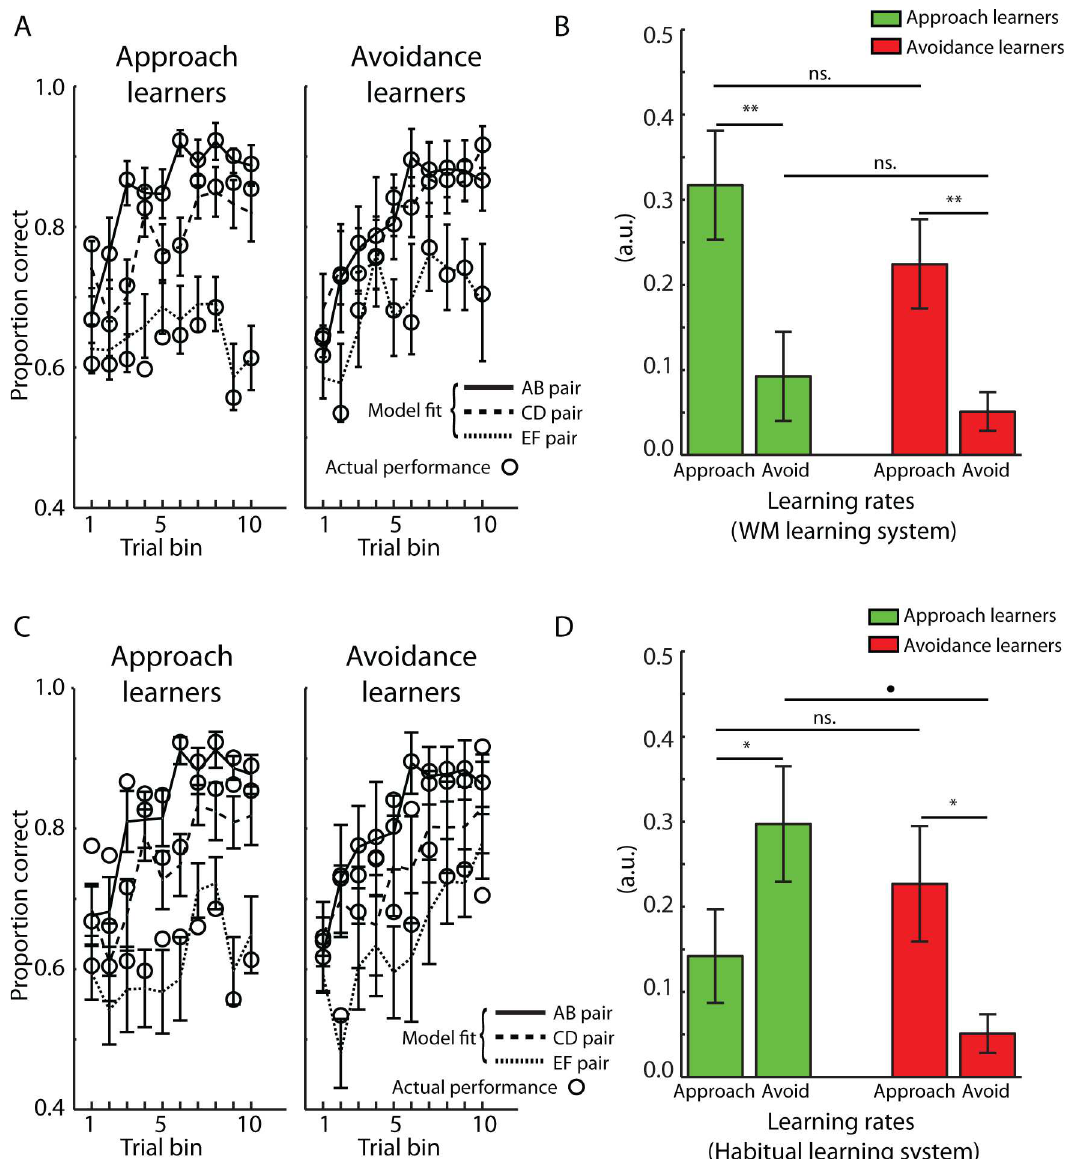
Fig 3. Model-fitted data (Mean ± SEM). A. To assess approachand avoidance learningin the workingmemory (WM) system, the approach/avoidancemodel was fit to participants’ behaviourduringthe trainingphase[12]. Model-derived proportionof correct selectionsduringthe training phaseis displayedby the lines, whileactual behaviour is displayedby the circles. B. Approachand avoidance learningrates for the WM system. Approachand avoidance learnersdid not differ in the learningrates for the WM system. C. To assess approach and avoidancelearningin the Habituallearningsystem, the approach/avoidancemodel was fit to participants’ behaviourduringthe testing phase [12]. Model-derived proportionof correct selectionsduringthe trainingphaseis displayedby the lines while actual behaviouris displayedby the circles. D. Approach and avoidancelearningrates for the Habituallearningsystem. Approachlearnersdisplayedrelatively slower learningrates from positive feedback( α Approach ) as comparedto negative feedback( α Avoid ), whileavoidancelearners displayedthe reverse trend. α Approach = learningrate followingpositive feedback, α Avoid = learningrate